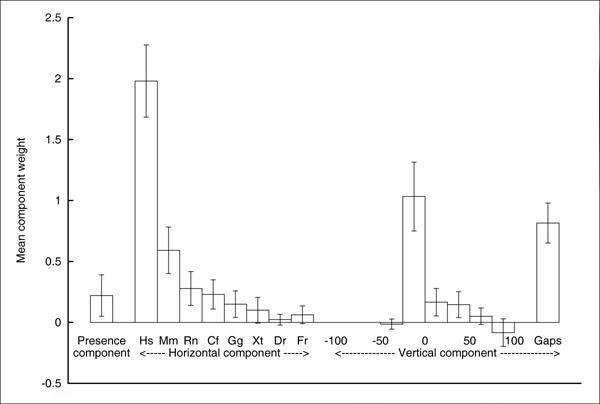
Mean RVM weights for horizontal and vertical component inputs. The figure shows the means, with p = 0.05 two-tail error bars, for weights assigned to inputs by acceptor site-type-pair RVMs in Classifier Two, averaging over all 20 pairings of decoy with true site types. The presence component has a single score. Two-letter abbreviations are used for the species-specific scores output by the horizontal component, while the vertical-component quantities are for eight 25 base-pair subregions (only six of which ever get non-zero scores) with one gap score. Species abbreviations are as in Figure 1.